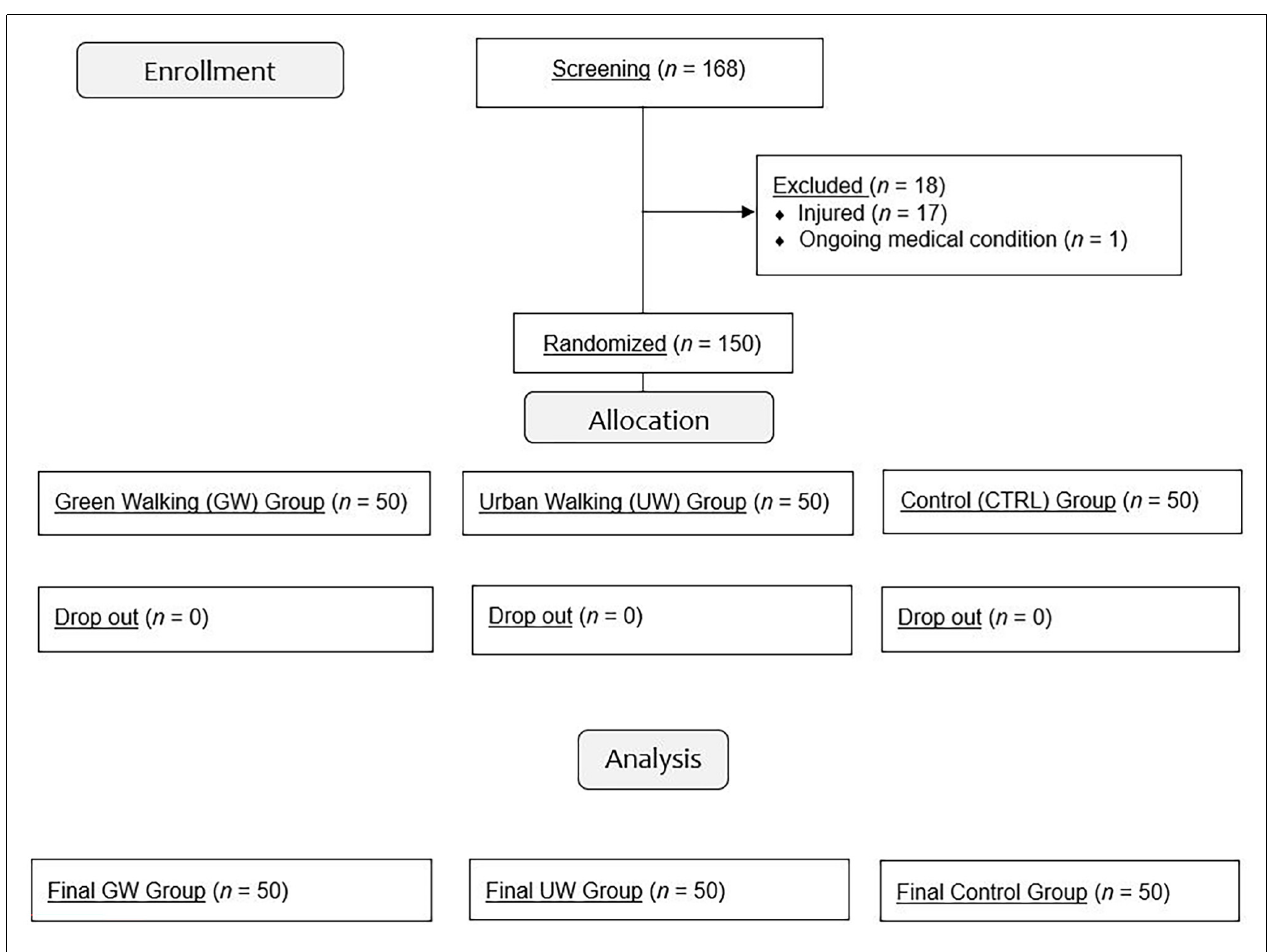
FIGURE 2 | Flowchart of study participants through the trial.